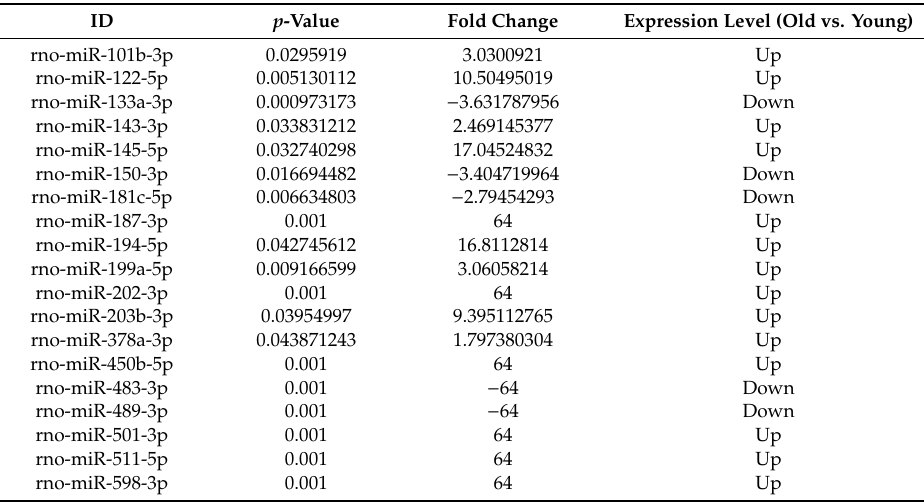
Figure 3. Profiles for differentially expressed miRNAs of serum exosomes from young and old rats. (A) Volcano plot showing the differentially expressed miRNAs (fold change > 1.5 and p < 0.05). (B) Venn diagram showing the differentially expressed mRNAs. (C) Venn diagram of the differentially expressed miRNAs. (D) Heat map of hierarchical clustering of 19 miRNAs that were identified in serum exosomes from young and old rats ( n = 6 each group). Table 1. List of circulating miRNAs for which expression di ff ered with